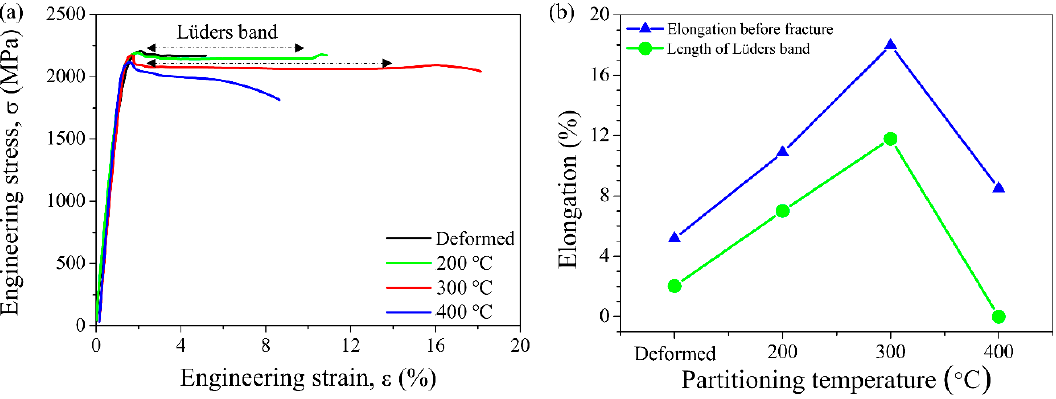
Figure 4. ( a ) The engineering stress–strain curves of D&P steels. ( b ) Effect of partitioning temperature on the ductility of D&P steels.